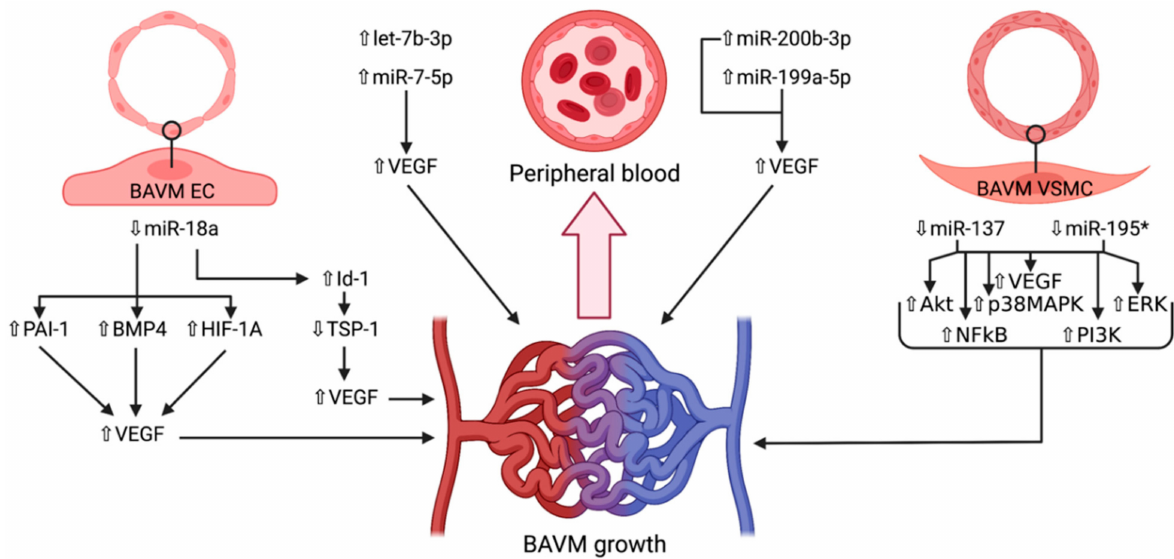
Figure 2. Schematic representation of the microRNAs and their respective expression levels, putative targets and pathways involved in the development of brain arteriovenous malformations. The microRNAs are divided according to the location wherein they were identified: brain endothelial cells, vascular smooth muscle cells, or peripheral blood. An upward pointing transparent arrow signifies upregulation; a downward pointing transparent arrow denotes downregulation. Abbreviations (in alphabetical order): Akt , protein kinase B; BAVM , brain arteriovenous malformation; BMP4 , bone morphogenetic protein; EC , endothelial cell; ERK , extracellular signal-regulated kinase; HIF-1A ; hypoxia inducible factor 1 α ; Id-1 , inhibitor of DNA-binding protein A; miR , microRNA; NFkB , nuclear factor kappa-light-chain of activated B cells; p38MAPK , p38 mitogen-activated protein kinase; PAI-1 , plasminogen activator inhibitor 1; PI3K , phosphoinositide 3-kinase; TSP-1 , thrombospondin 1; VEGF , vascular endothelial growth factor; VSMC , vascular smooth muscle